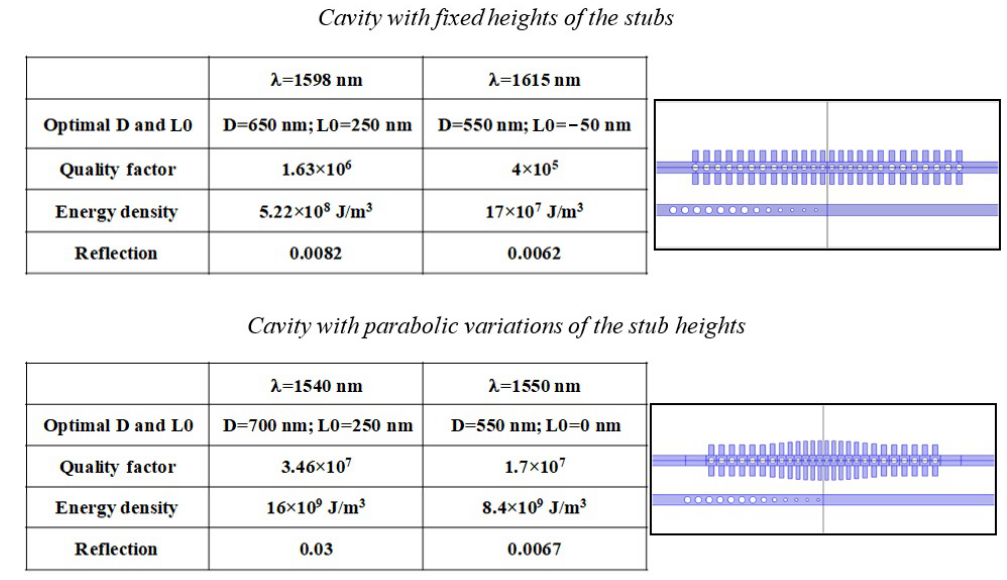
Figure 10. Optical features of uniform and tapered cavities: comparison of numerical results.